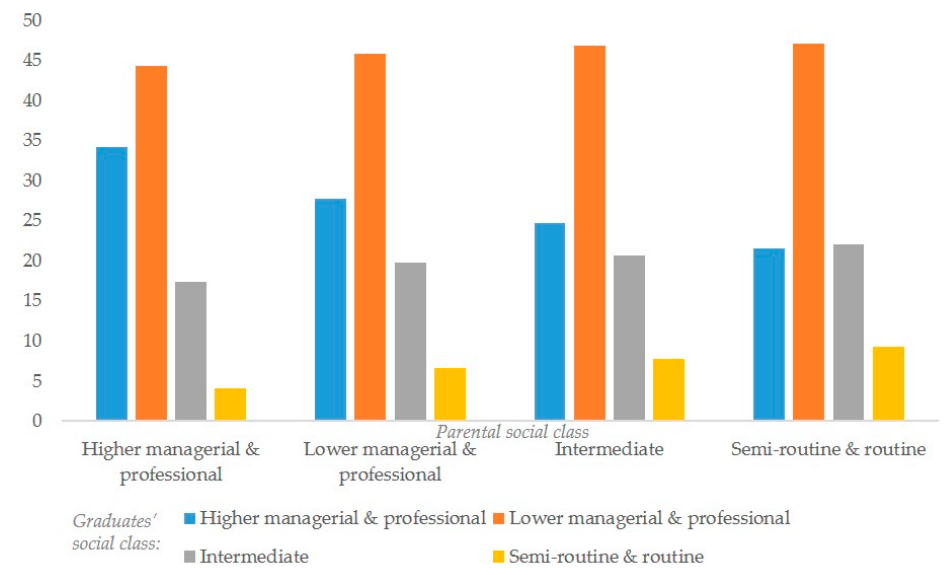
Figure 1. Graduates’ parental social class and their social class 3.5 years after graduation (weighted